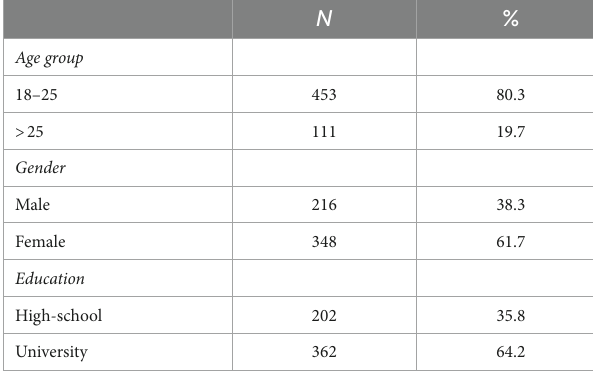
TABLE 1 Sample demographics ( N =